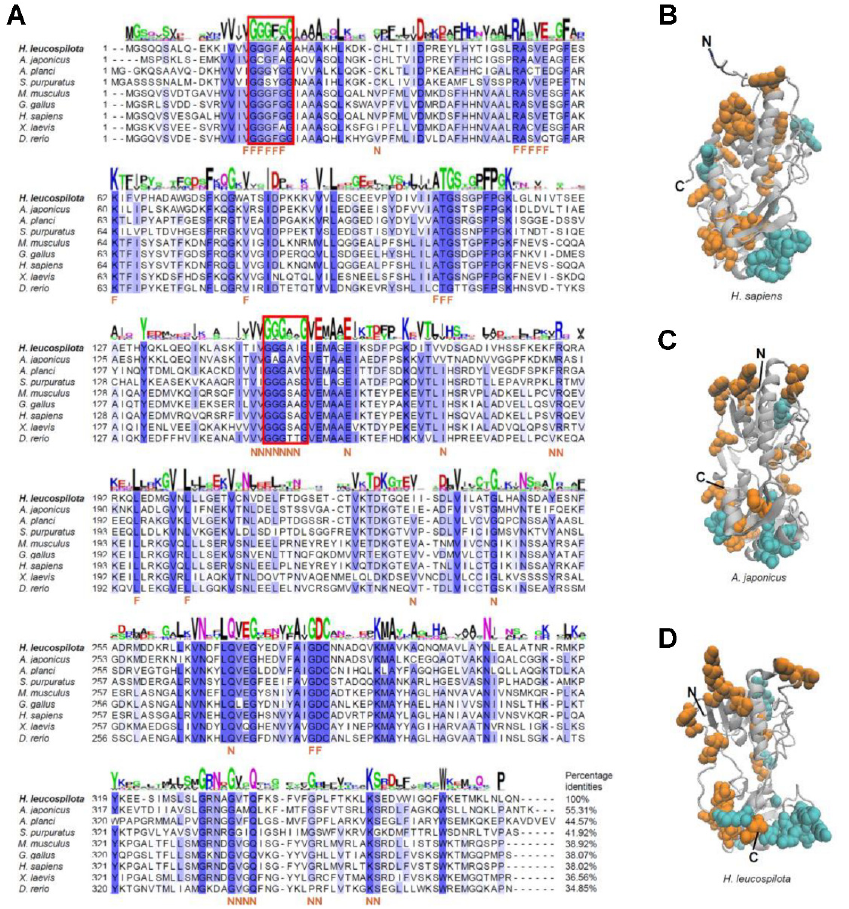
Figure 2. Sequence alignment and three-dimensional (3-D) structure of AIF-2 in different species. ( A ) A.a. sequence alignment of AIF-2 in nine Deuterostomia species. The conserved a.a. residues of H. leucospilota are presented in WebLogo format, and the conserved and similar a.a. residues between different species are labeled in dark blue and light blue, respectively. Residues that interact with FAD or NAD (in H. leucospilota ) are marked as “F” or “N”, respectively. Two core consensus sequences of the typical motif “GXGXXG” are boxed in red lines. ( B – D ) Comparison of the 3-D protein of AIF-2 among human H. sapiens and the sea cucumber A. japonicus and H. leucospilota . Space-filling symbols indicate the most conserved binding sites of FAD (orange) and NAD (blue).